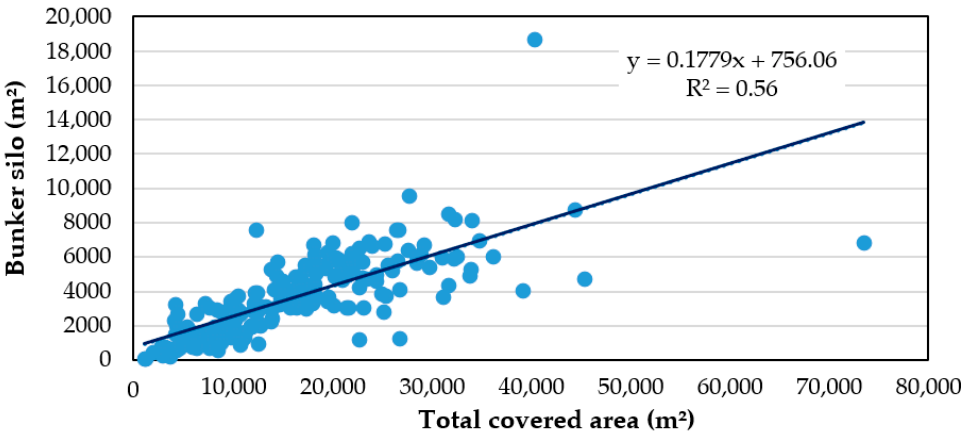
Figure 6. Correlation between storage areas and total covered